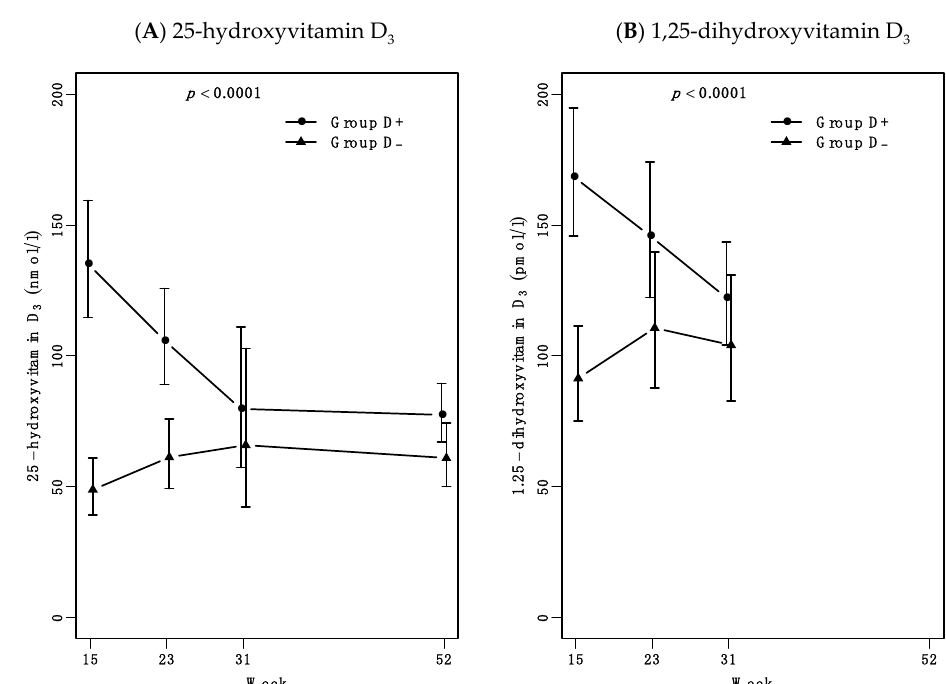
Figure 3. 25-hydroxyvitamin D and 1.25-dihydroxyvitamin D levels during follow-up. Results are presented as estimated medians with 95% confidence interval (CI), p value represent mixed model test for parallel curves. ( A ). 25-hydroxyvitamin D 3 levels were dependent of vitamin D treatment as expected. At week 31 group D+ had decreased to comparable levels with group D-. ( B ). Active 1.25-dihydroxyvitamin D 3 levels week 15 to 31 were also depended of vitamin D